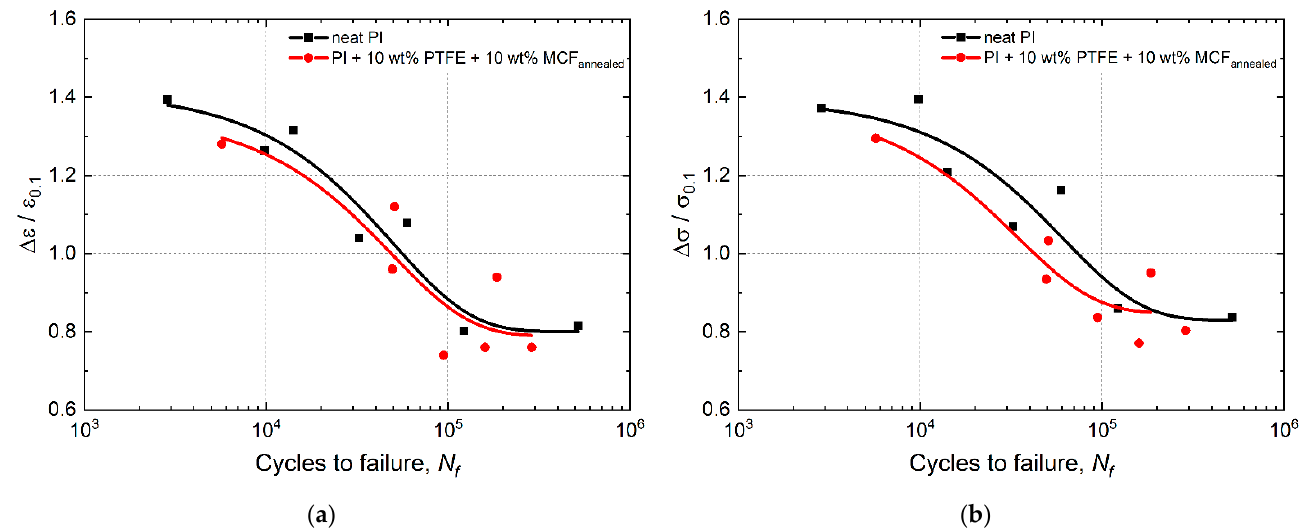
Figure 7. The strain ( a ) and stress ( b ) fatigue curves for neat PI and the “PI/PTFE/MCF” composite normalized over the yield point.